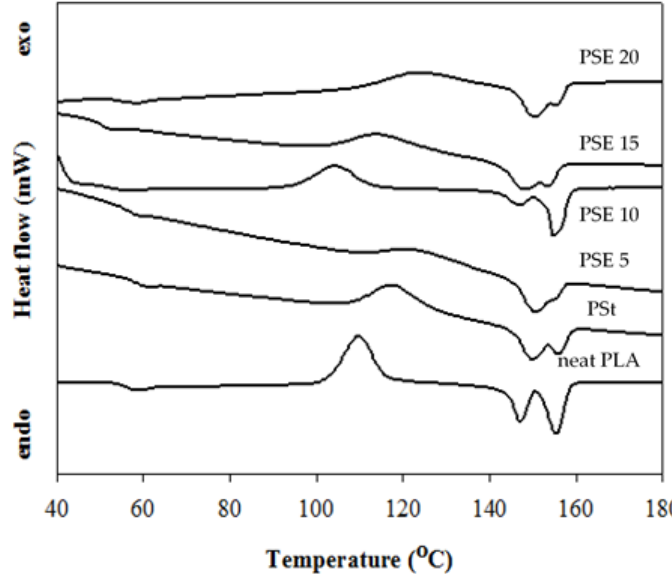
Figure 1. Differential scanning calorimetry (DSC) thermograms of neat PLA, PLA/starch (PSt), and PSE blends. Table 2. Thermal Properties of neat PLA, PSt, and PSE blends.